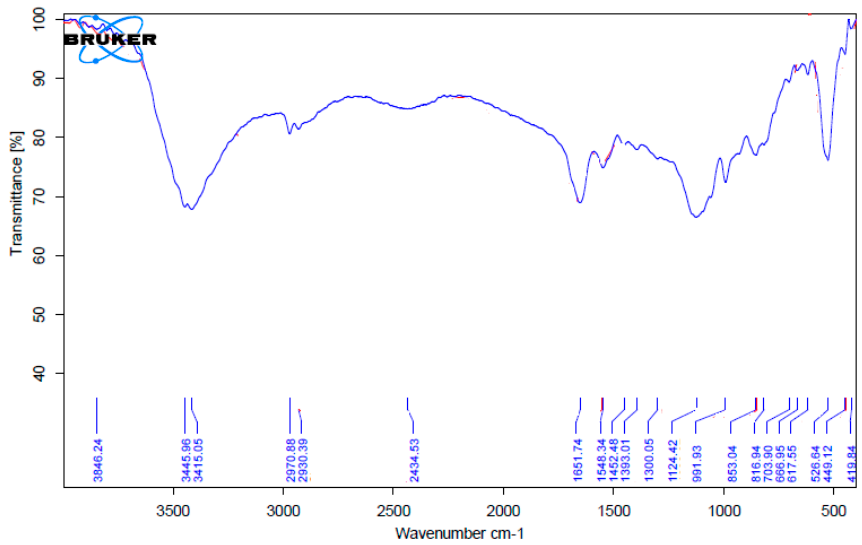
Figure 4. Fourier transform infrared spectroscopy of zirconium magnetic nanocomposite.